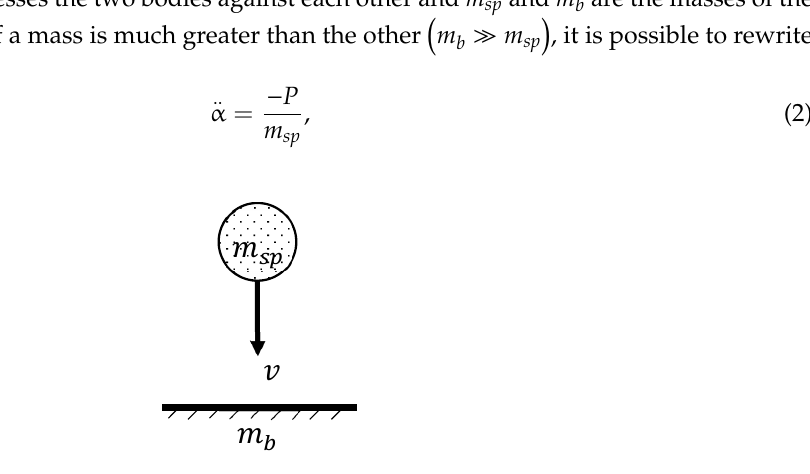
Figure 1. A Hertzian distribution of contact pressure .